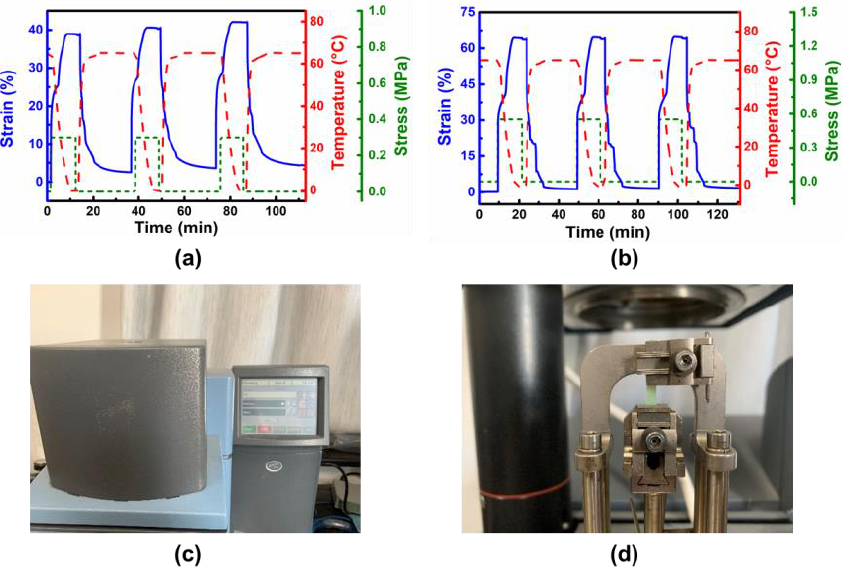
Figure 3. Shape-memory properties of samples doped by Ni 2+ ( a ) and Co 2+ ( b ). The photos of the DMA machine ( c ) and the loading cabin ( d ).